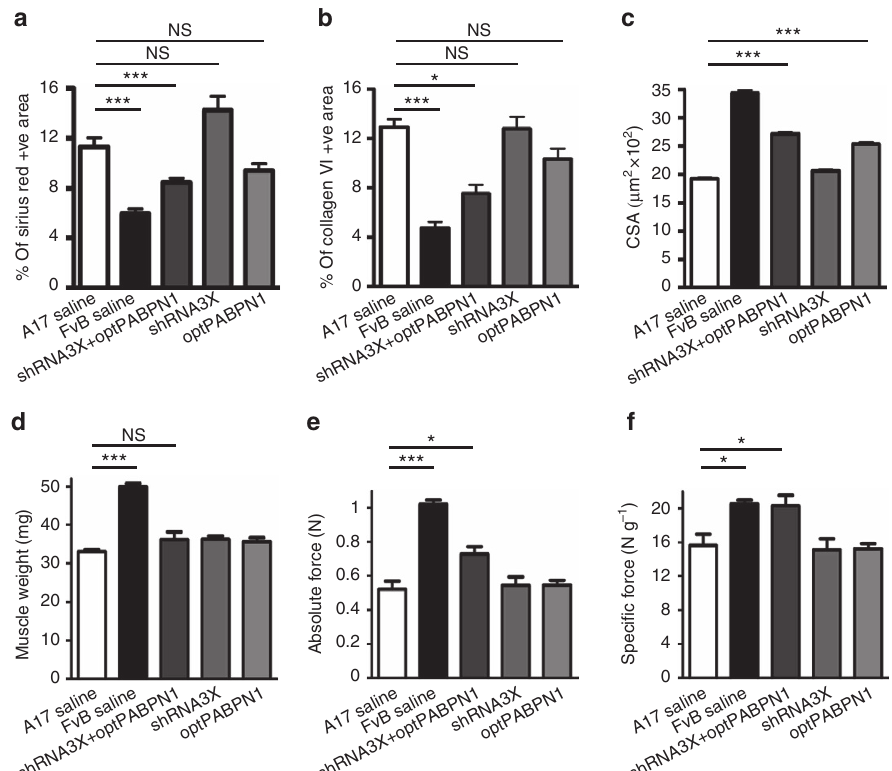
Figure 4 | In vivo co-administration of AAV-shRNA3X and AAV-optPABPN1 diminishes muscle fibrosis and myofibre atrophy and improves the functionality of treated muscles. ( a , b ) Morphometric evaluation of Sirius red staining ( a ) or collagen VI immunostaining ( b ) in treated muscles of 30-week-old mice shows a significant reduction in fibrosis in muscles treated with AAVs expressing a combination of shRNA3X and optPABPN1 compared to saline-treated muscles. ( c ) The average of myofibre sizes per group shows that myofibres of muscles treated with AAV-optPABPN1 only or in combination with AAV-shRNA3X are larger than myofibres of muscles treated with saline. ( d ) Eighteen weeks after AAVs injection no difference was detected in the muscle weight of AAV-treated muscles compared to saline-injected TA of A17 mice. ( e ) Maximal force generated by TA muscles of treated mice was measured by in situ muscle physiology, co-injecting AAV-shRNA3X and AAV-optPABPN1 significantly increased the absolute maximal tetanic force generated by TA muscles. ( f ) Normalization of maximal force by muscle weight provides a measure of the muscle strength per unit of skeletal muscle called specific maximal force. The co-injection of the two AAVs normalized the specific maximal force of TA muscles to the level detected by wild-type muscles. Data are represented as mean ± s.e.m. a – c : n ¼ 6 (saline-treated A17 or FvB muscles) or n ¼ 8 (all the other groups). d – f : n ¼ 8 (saline-treated A17 or FvB muscles) or n ¼ 10 (all the other groups). One-way ANOVA test with Bonferroni post-hoc test, * P o 0.05, *** P o 0.001, NS, not